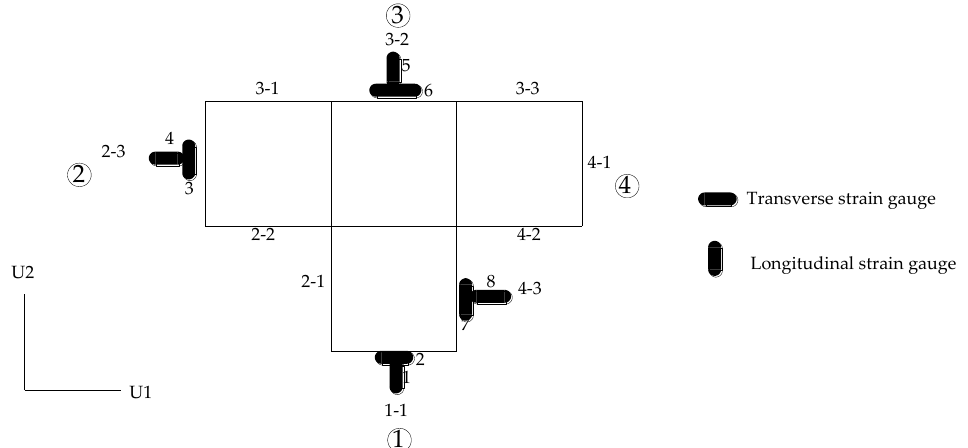
Figure 2. Numbering rules and measuring points for specimens.